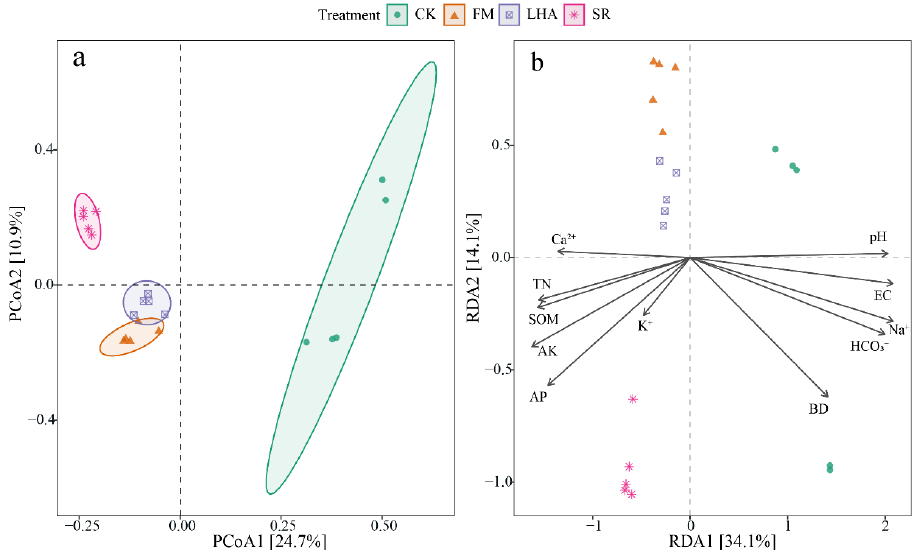
Figure 5. Principal coordination analysis (PCoA) ( a ) of the bacterial community structure and redundancy analysis (RDA) ( b ) of the relationship between environmental factors and bacterial community based on Bray–Curtis dissimilarity.